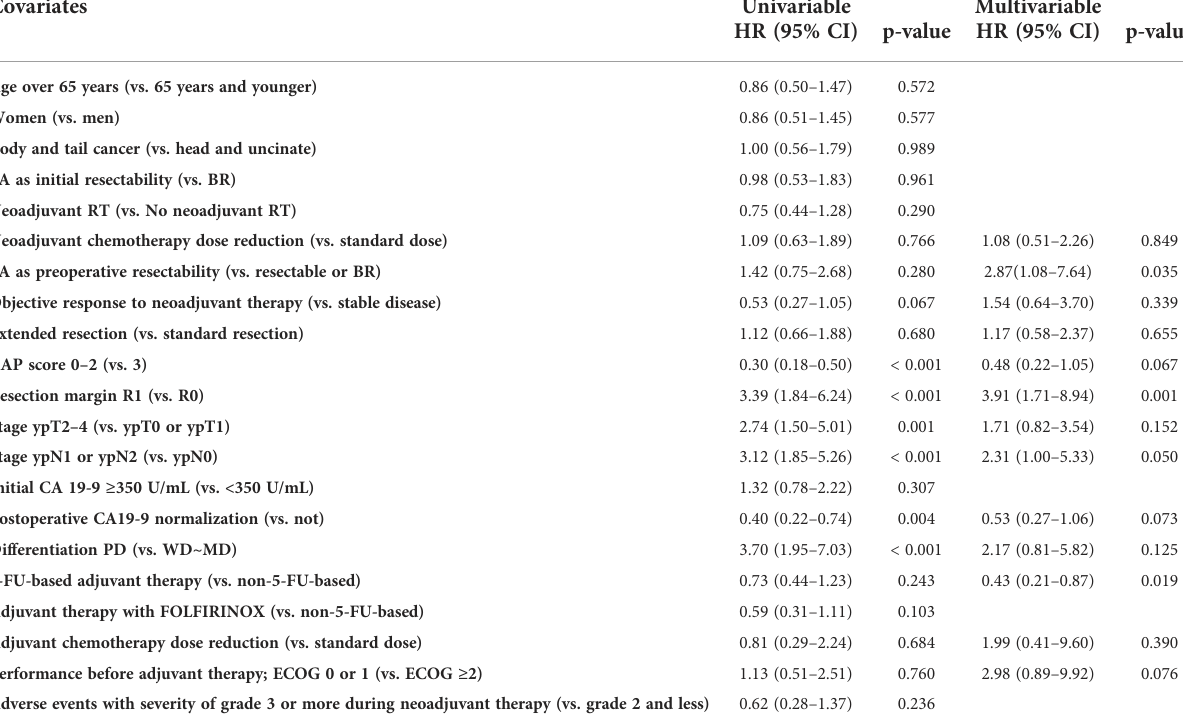
TABLE 3 Prognostic factors for recurrence by multivariable Cox proportional hazards